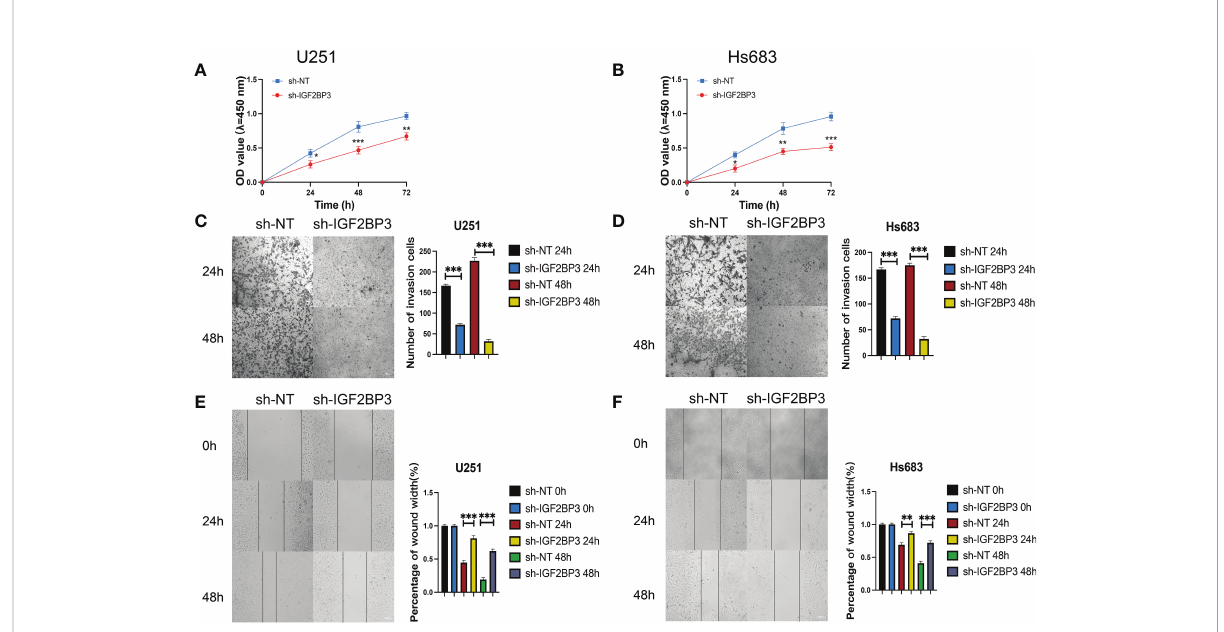
FIGURE 10 IGF2BP3 knockdown impairs glioma cell proliferation, migration, and invasion. (A, B) Cell proliferation ability of U251 and HS683 cells transfected with sh-IGF2BP3 was evaluated by CCK8 assay. (C, D) Cell migration capability of U251 and HS683 cells transfected with sh- IGF2BP3 was evaluated by wound healing assays. (E, F) The in- fl uence on cell migration and invasion abilities of U251 and HS683 cells transfected with sh-IGF2BP3 was assessed by transwell migration invasion assays. Bar: 100 m m. *P < 0.05, **P < 0.01, ***P <